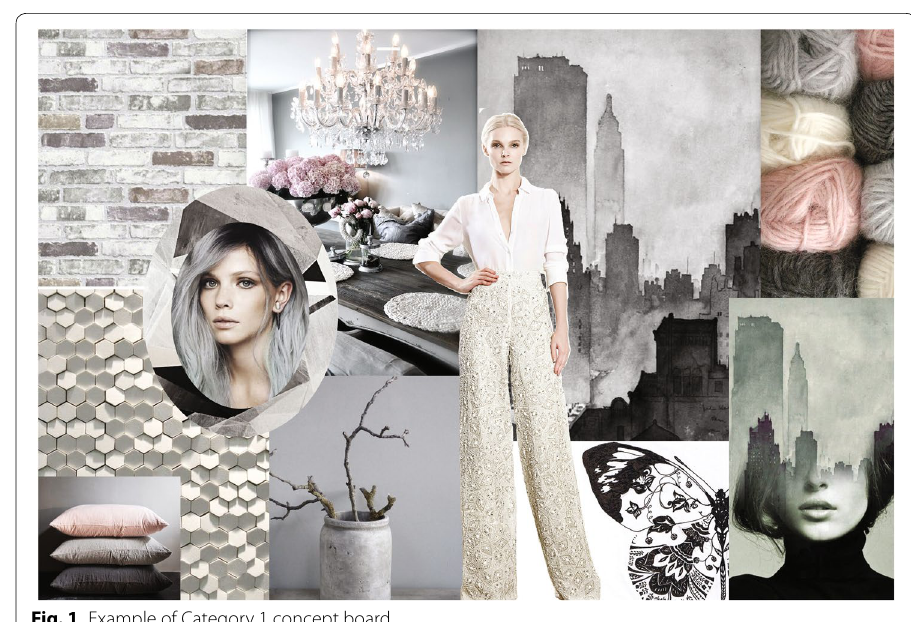
Fig. 1 Example of Category 1 concept board